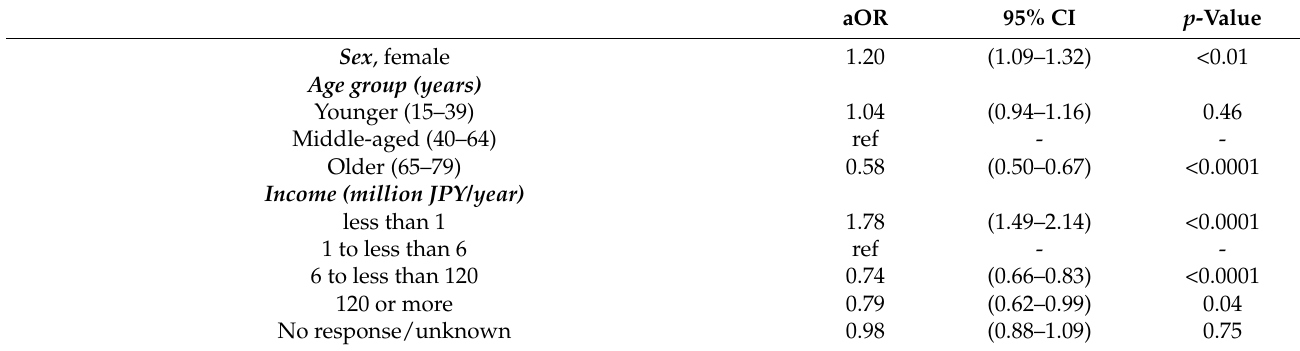
Table 4. Multivariate logistic regression models for odds ratio of COVID-19 vaccine